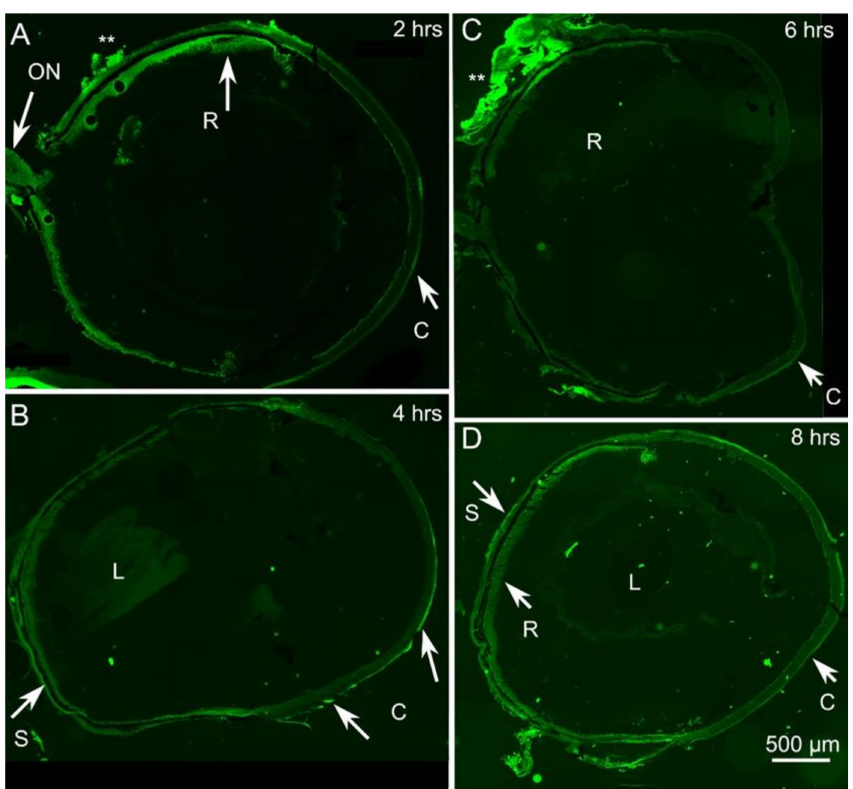
Figure 3. LN-ODAF diffusion to ocular structures. ( A – D ) Progressive invasion of the green fluo- rescence signal in time. C: cornea; ON: optic nerve; R: retina; S: sclera. L: Lens. Asterisks in ( A , C ) indicate periocular structures abutting areas of bright fluorescent staining of the underlying retina, suggesting outer-to-inner diffusion at focal